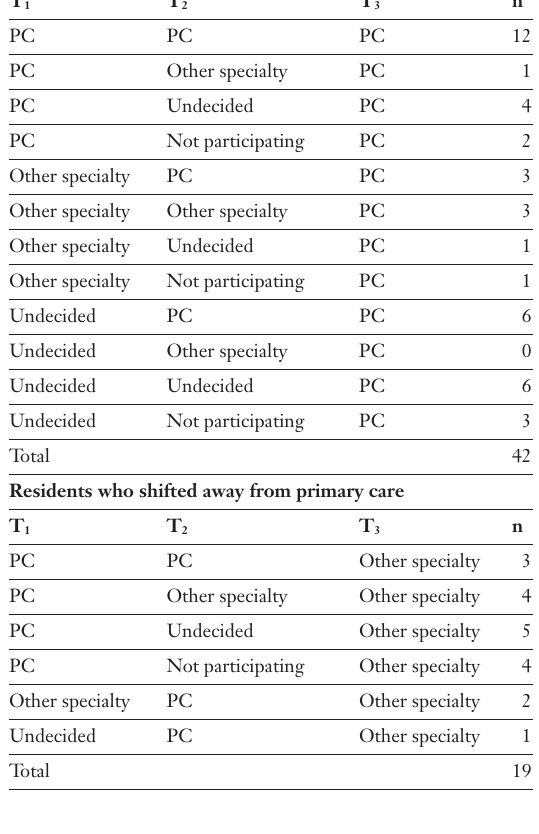
Socio-demographic characteristics of physicians aspiring to primary care and other specialties